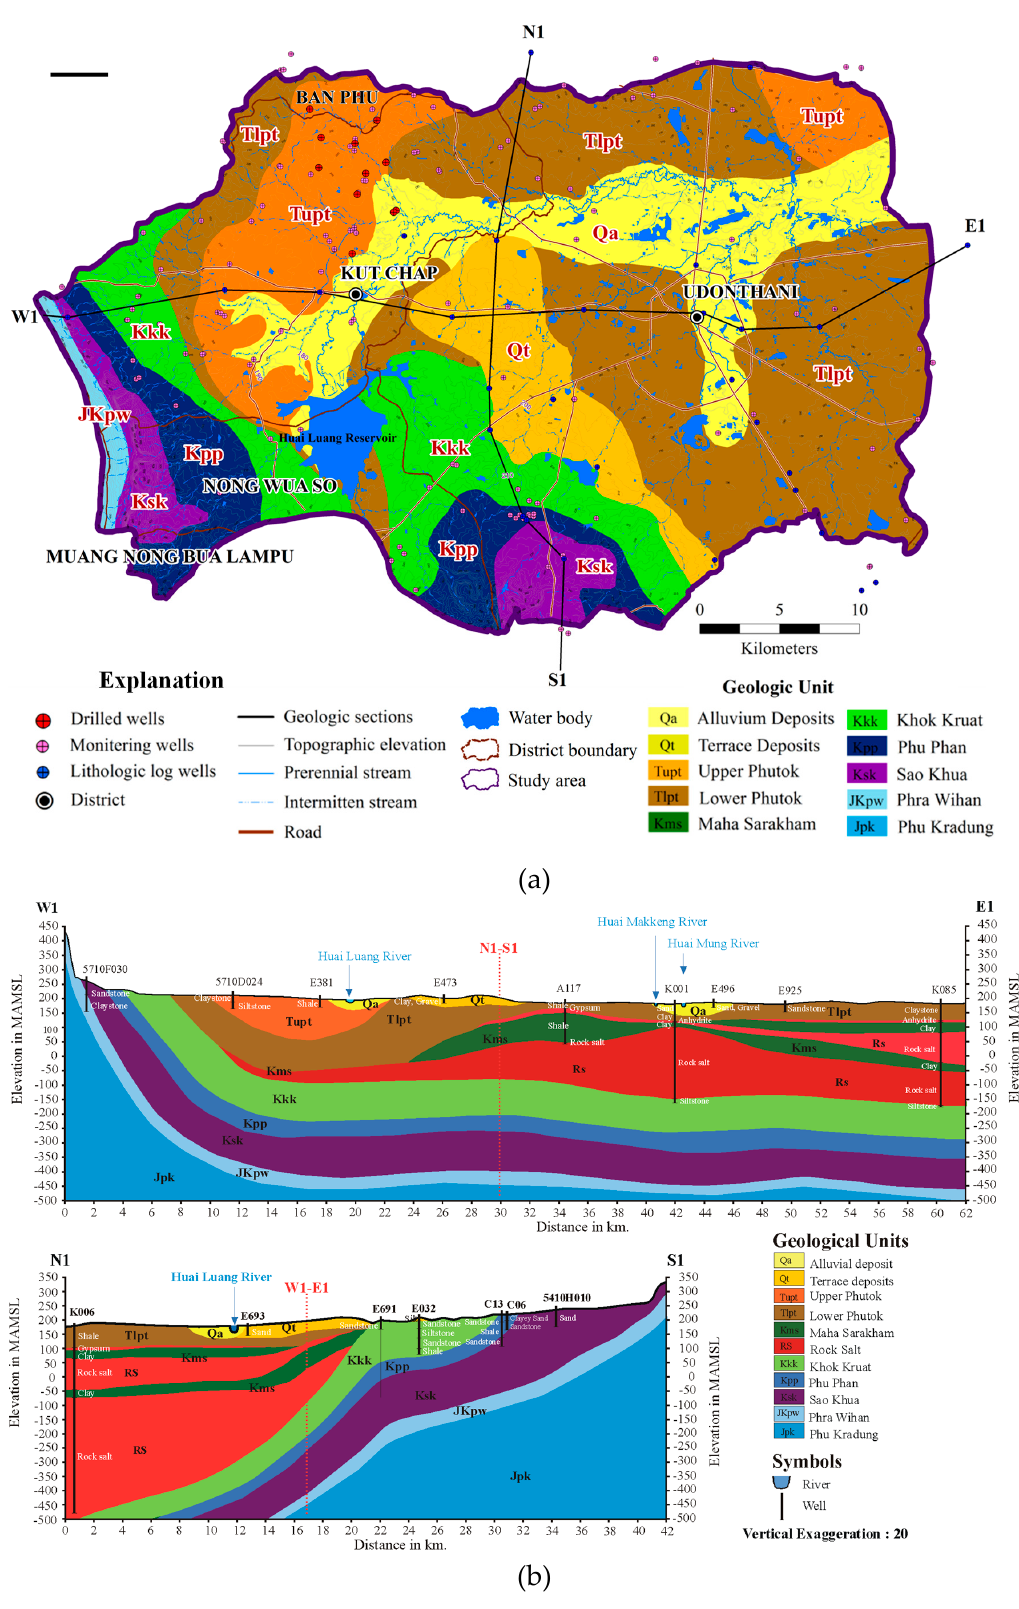
Figure 3. Geologic map and cross sections. ( a ) geologic map of CHLB; and ( b ) geologic cross sections along lines W1 ‒ E1 and N1 ‒ S1.